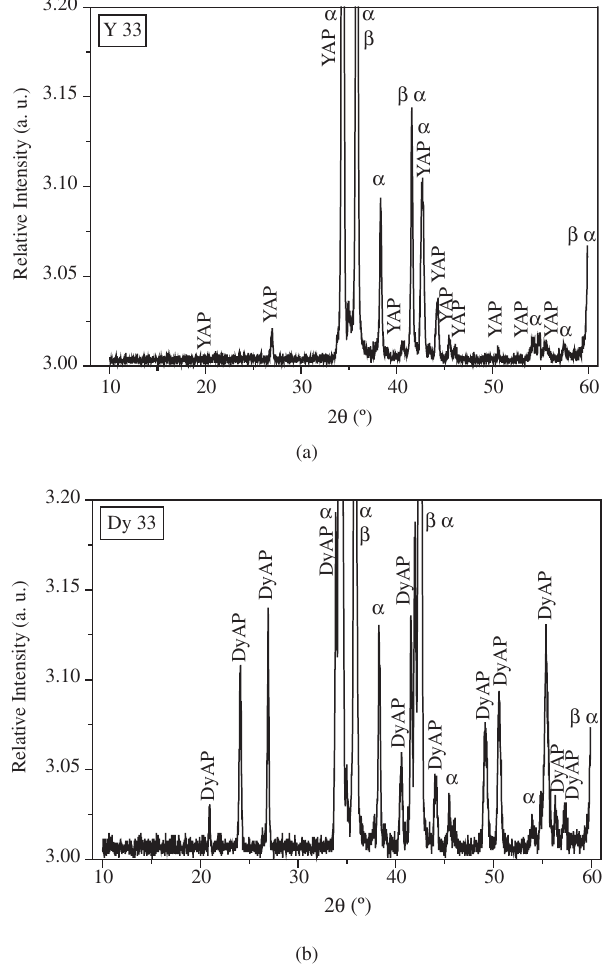
Figure 2. X-ray diffratograms patterns of RE 33 samples sintered at 1800 °C/1h: a) RE = Y; b) RE =